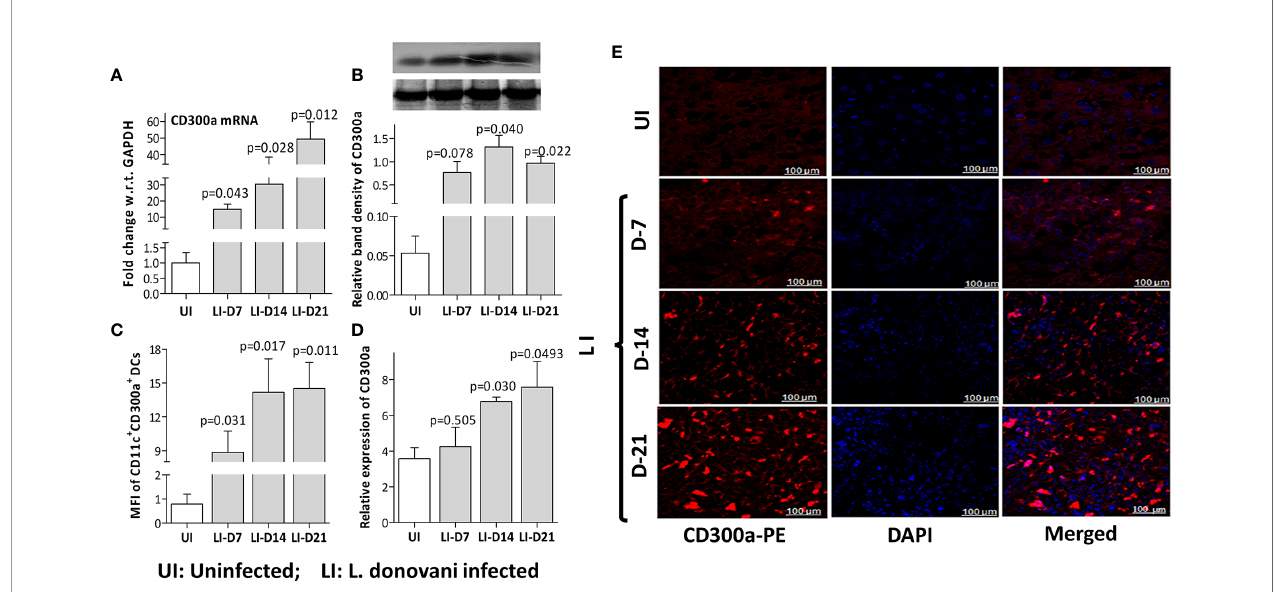
FIGURE 2 | The CD300a mRNA and protein expression levels in the spleen of L. donovani infected mice. Mice (n=6 per group), infected with 3×10 6 stationary phase promastigotes via tail vein, were evaluated post 7 (D-7), 14 (D-14), and 21 (D-21) days of infection. The expression levels of CD300a mRNA (A) and protein (B) were signi fi cantly elevated in infected mice with the passage of time as compared to day 7. (C) . The number of CD300a expressing CD11c+ dendritic cells in the spleen, measured as Mean Fluorescent Intensity (MFI) by fl ow cytometry, were found signi fi cantly increased at all time points post-infection. An unvarying expression of CD300a was observed in the spleen tissues (E) that increased with the passage of time in the infected animals (D) . The uninfected (UI) animals were used as a control for comparison to determine statistical signi fi cance